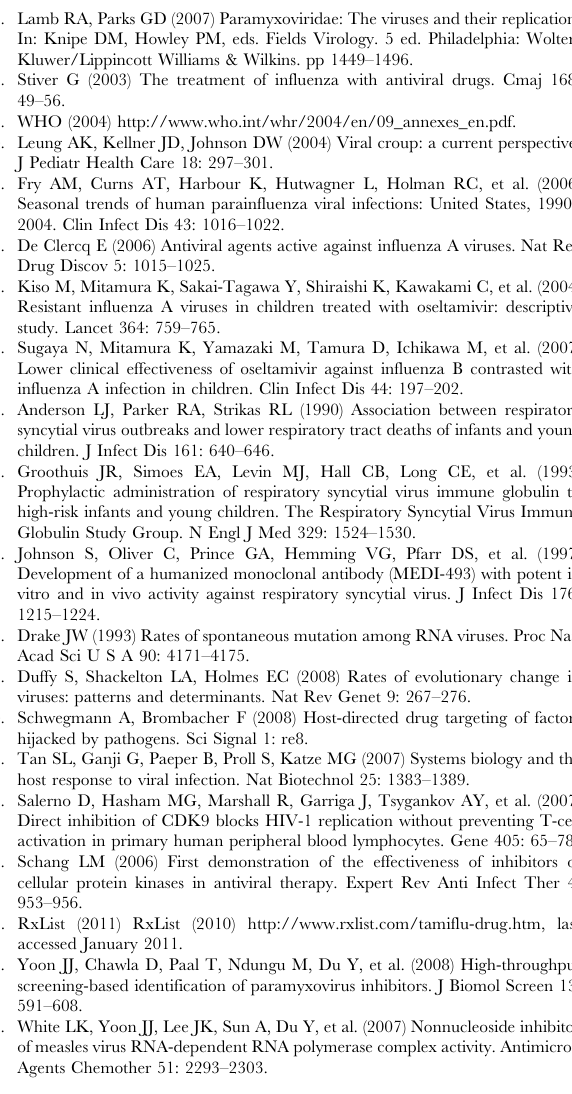
Figure S2 Structure of RDEA-806.